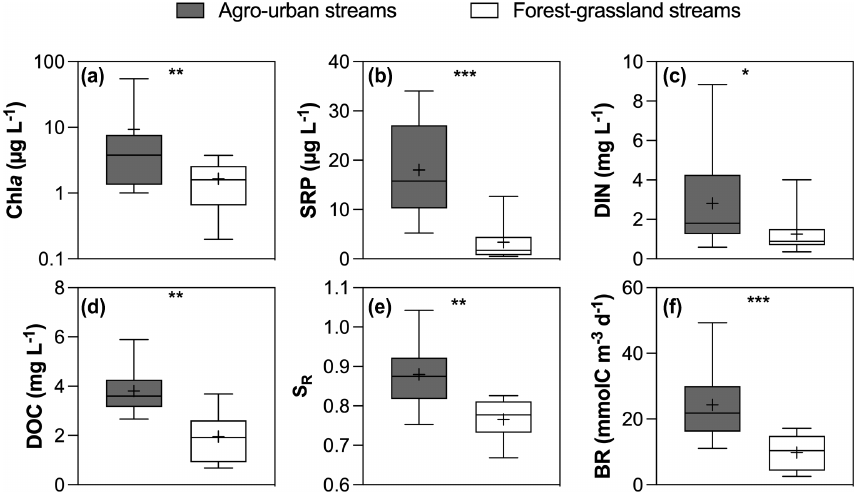
Figure 2. Boxplots of (a) Chl a , (b) SRP, (c) DIN, (d) DOC concentrations and (e) S R values and (f) BR in agro-urban (grey) and forest– grassland (white) streams. The box represents the first and third quartile, the horizontal line corresponds to the median, the cross corresponds to the average, and the error bars correspond to the maximum and minimum. Mann–Whitney unpaired t tests were used to test for statistical differences: ns represents not significant, ∗= p < 0.05, ∗∗= p < 0.01, ∗∗∗= p < 0.001, ∗∗∗∗= p < 0.0001.